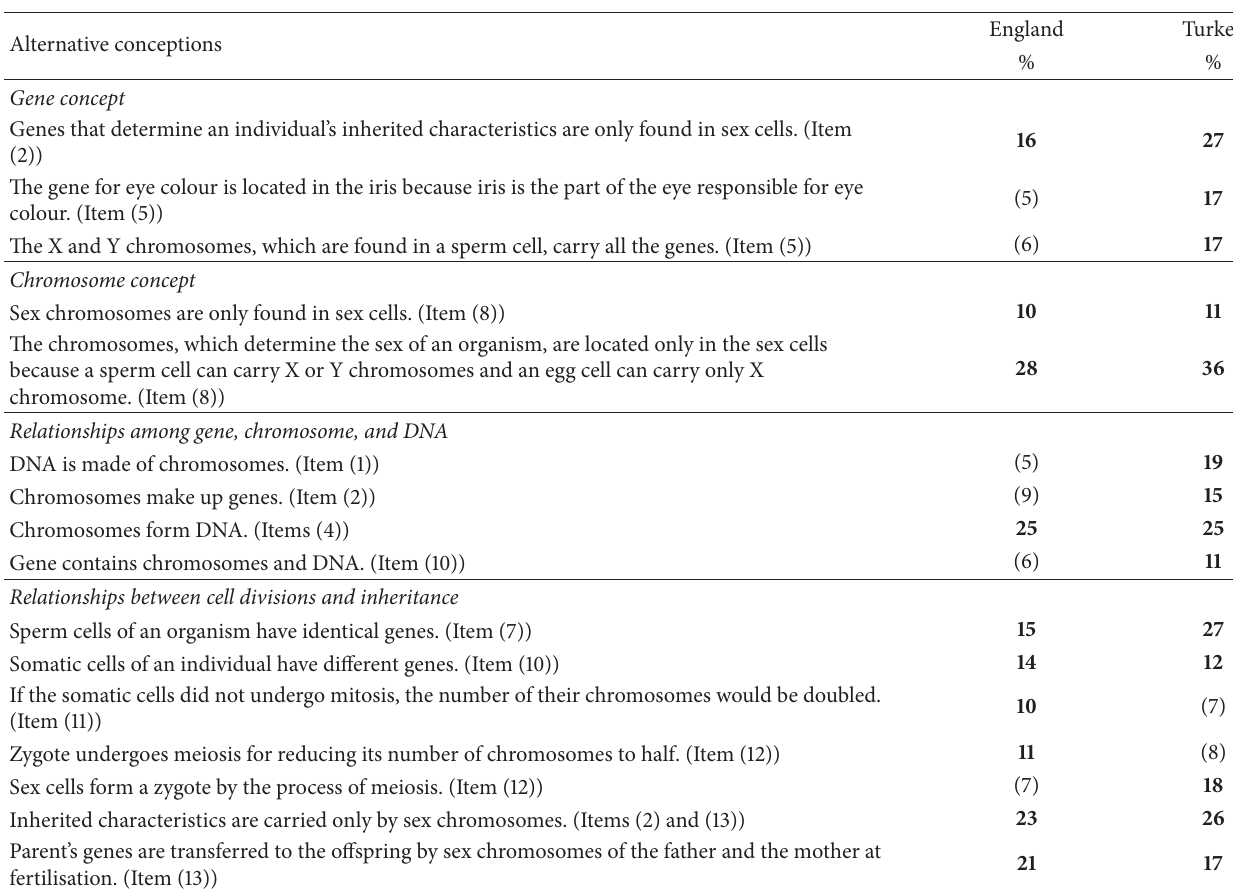
Table 3: Students’ alternative conceptions displayed in their understanding of fundamental genetics concepts. Alternative conceptions Gene concept